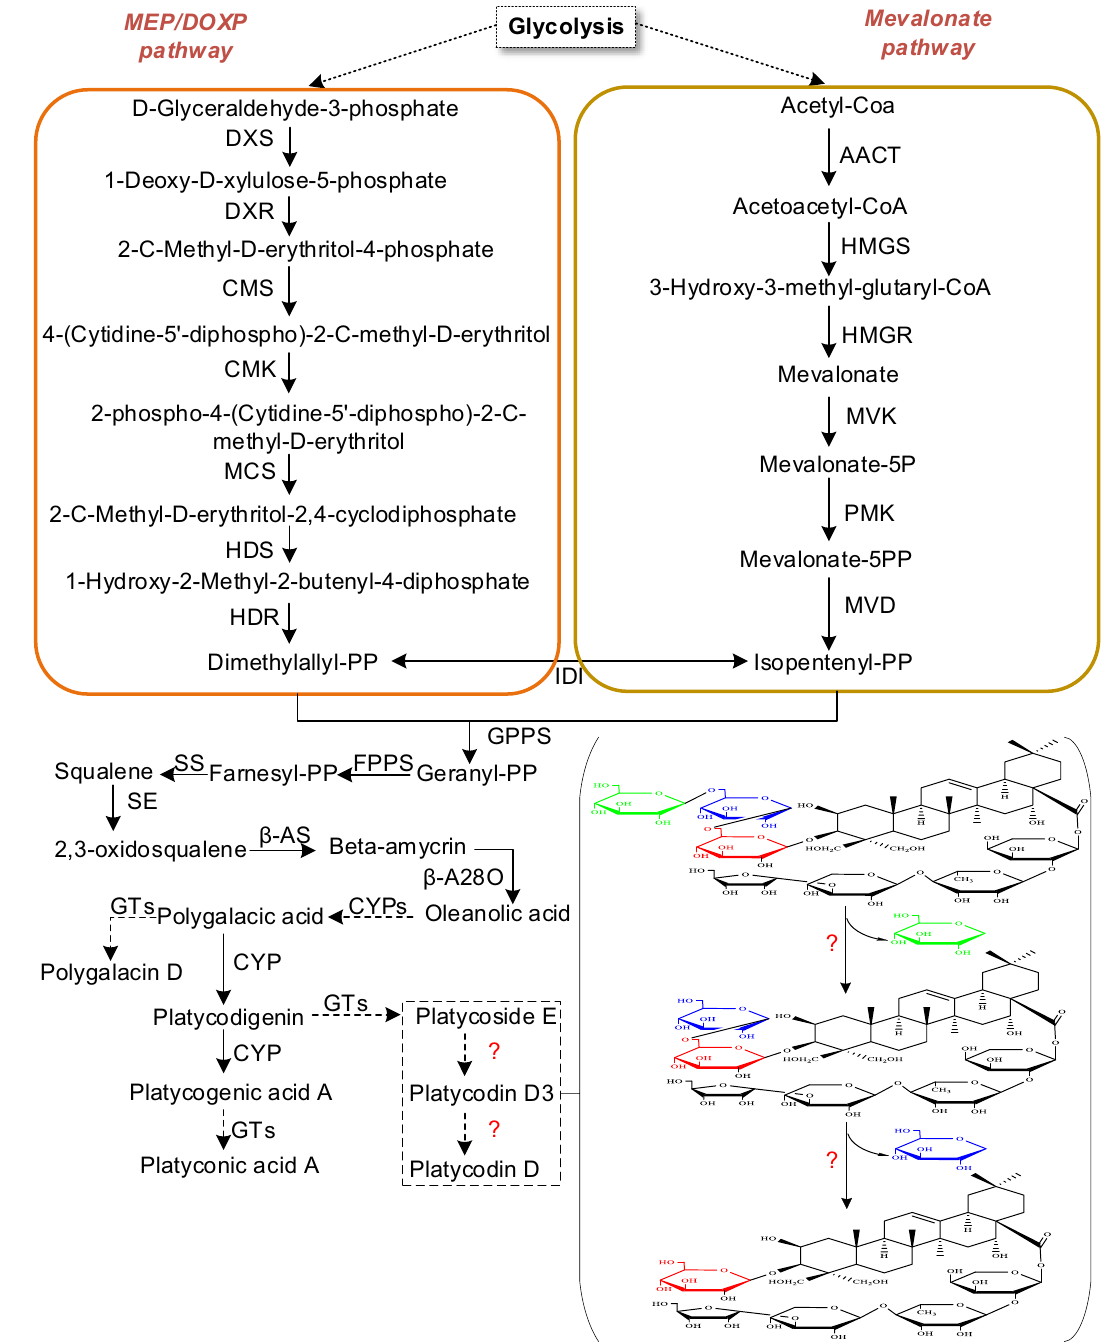
Figure 1. Triterpenoid saponin biosynthetic pathways predicted in P . grandiflorus . Arrows with solid lines represent the identified enzymatic reactions, and arrows with dashed lines represent multiple enzymatic reactions through multiple steps and putative enzymatic